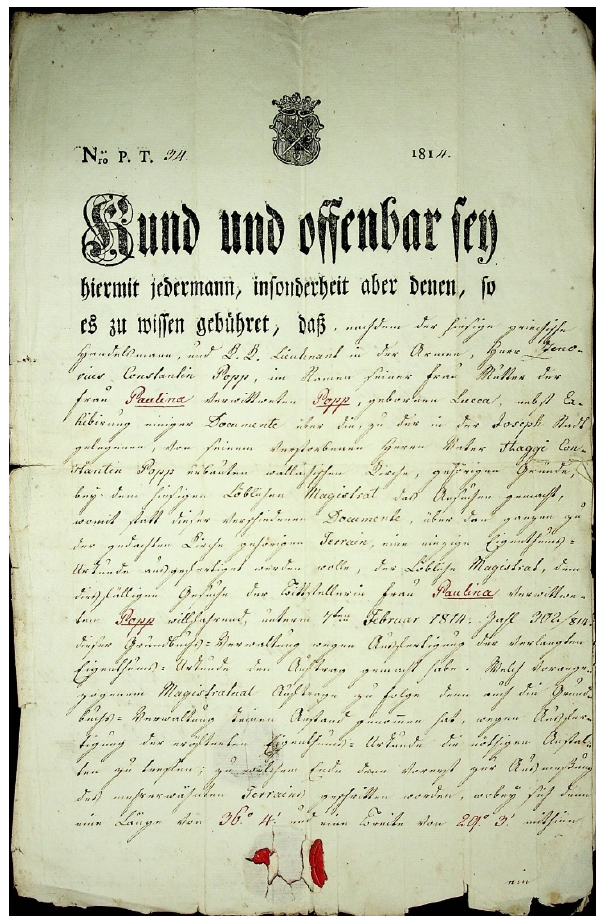
Figure 2. First page of the document.